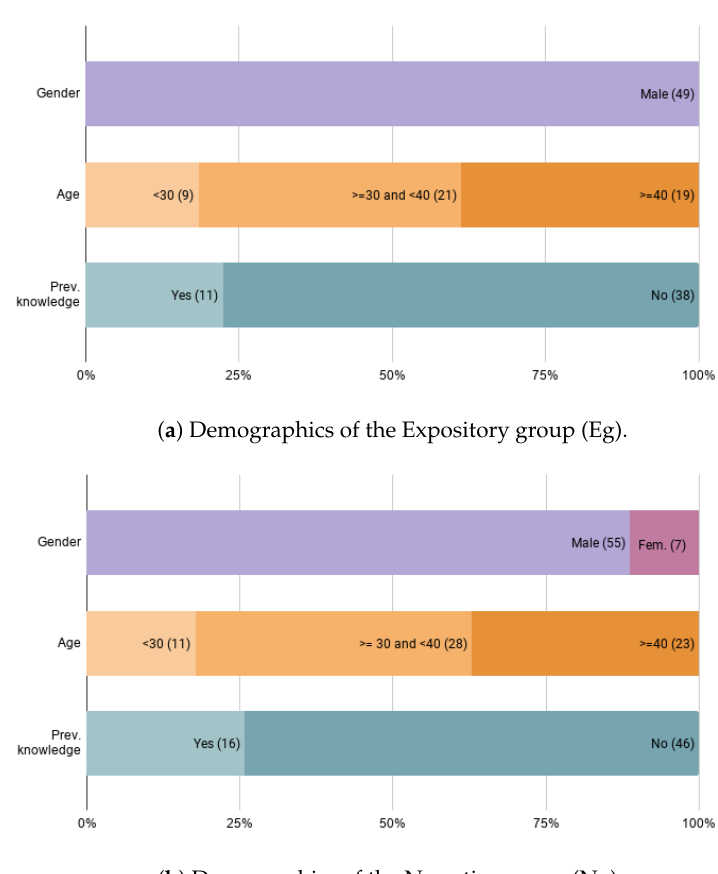
Figure 3. Demographics of the subjects participating in the